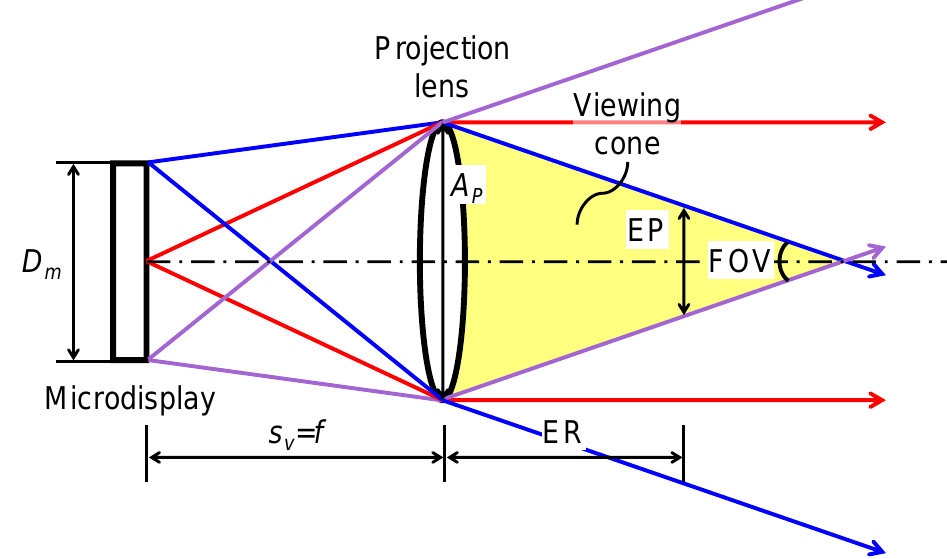
Figure 3. Optical path diagram of the pico projector. D m is the size of the microdisplay, s v the virtual object distance, f the focal length of the projection lens, A p the aperture of the projection lens, FOV the field of view, ER the eye relief, and EP the exit